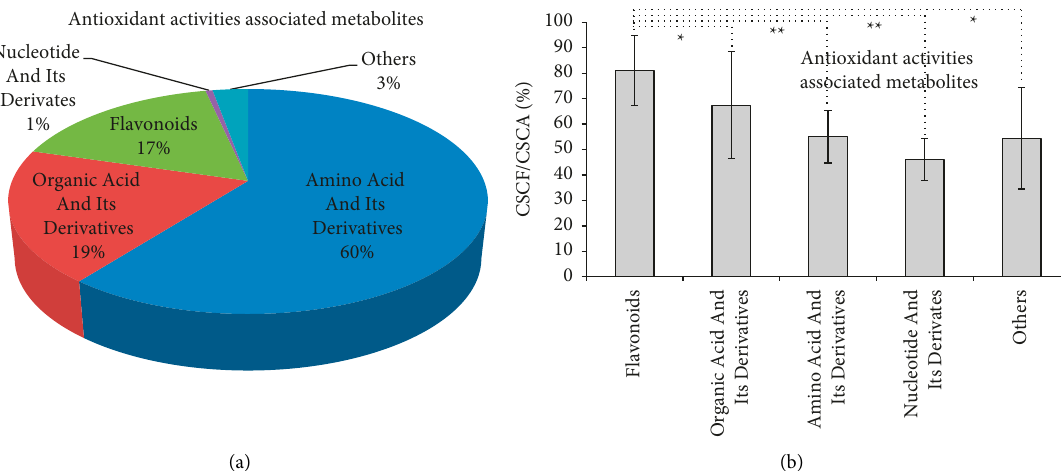
Figure 5: Distribution of antioxidant activities associated metabolites in flower of D. nobile . (a) Relative distribution in flower ( n � 72). (b) Proportion in flower compared to root, stem, leaf, and fruit. CSCF/CSCA the contents of one specific component in flower to the contents of this component in all of root, stem, leaf, flower, and